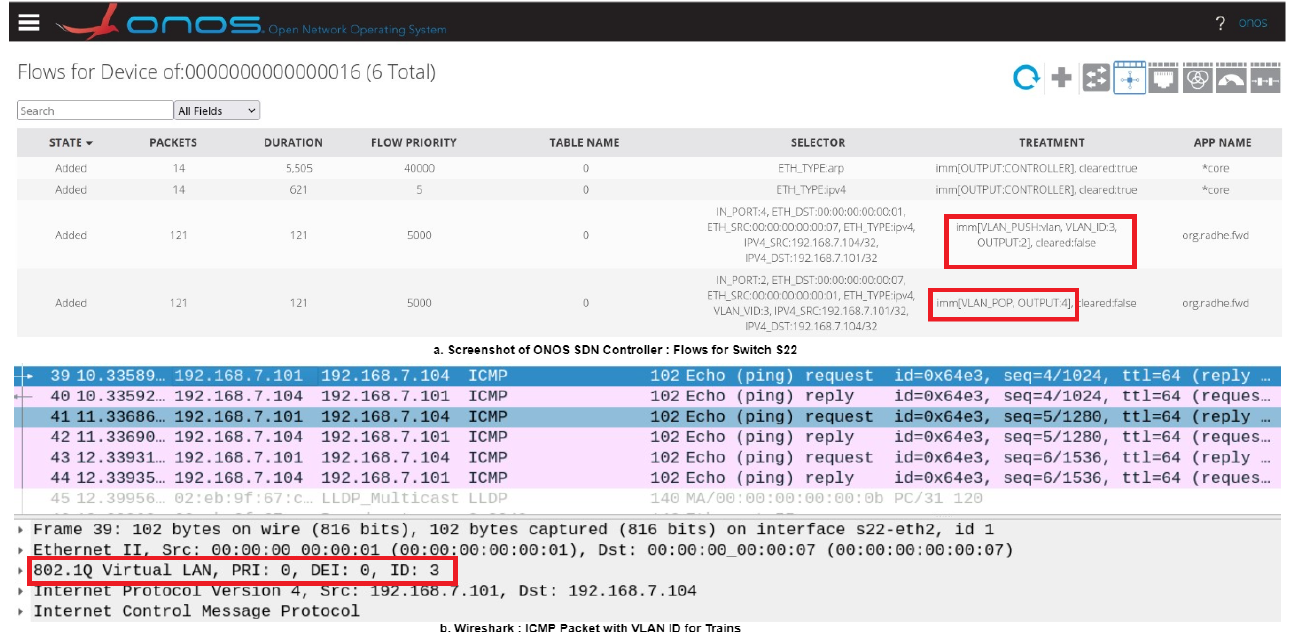
Figure 20. Flow entries for switch S22: VLAN ID assignment to car’s data packet.